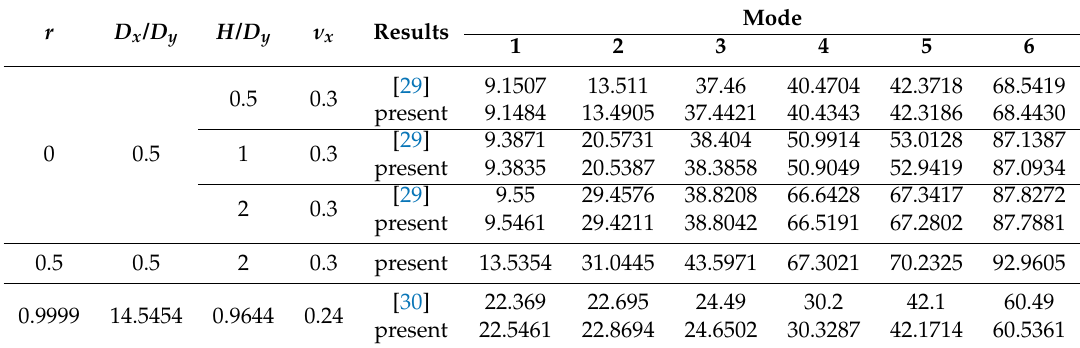
Table 2. First six frequency parameters Ω = ω a 2 three different rotational fixity factors.